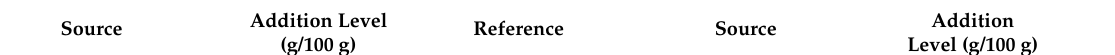
Table 1. Summary of studies exploring dietary fiber application in gluten-free bread formulations, including source and addition